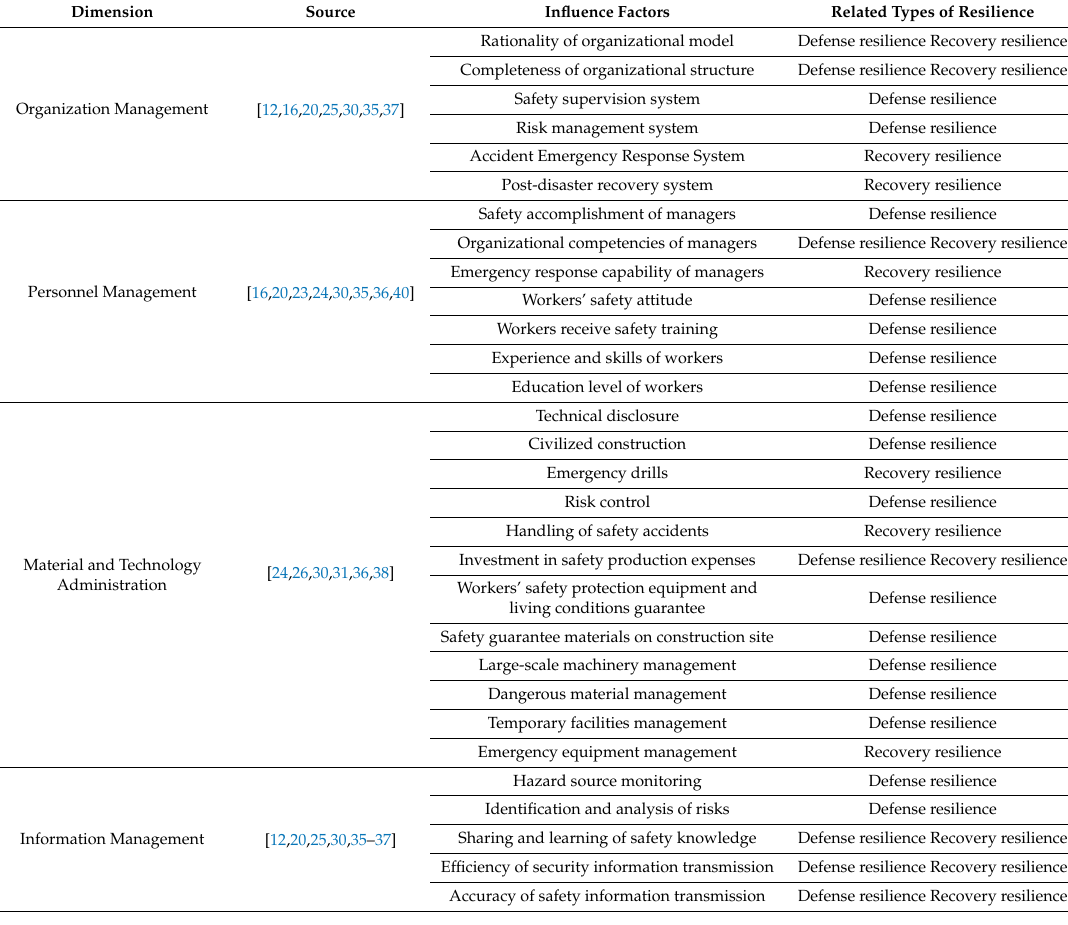
Table 1. Construction safety factors based on resilience theory.